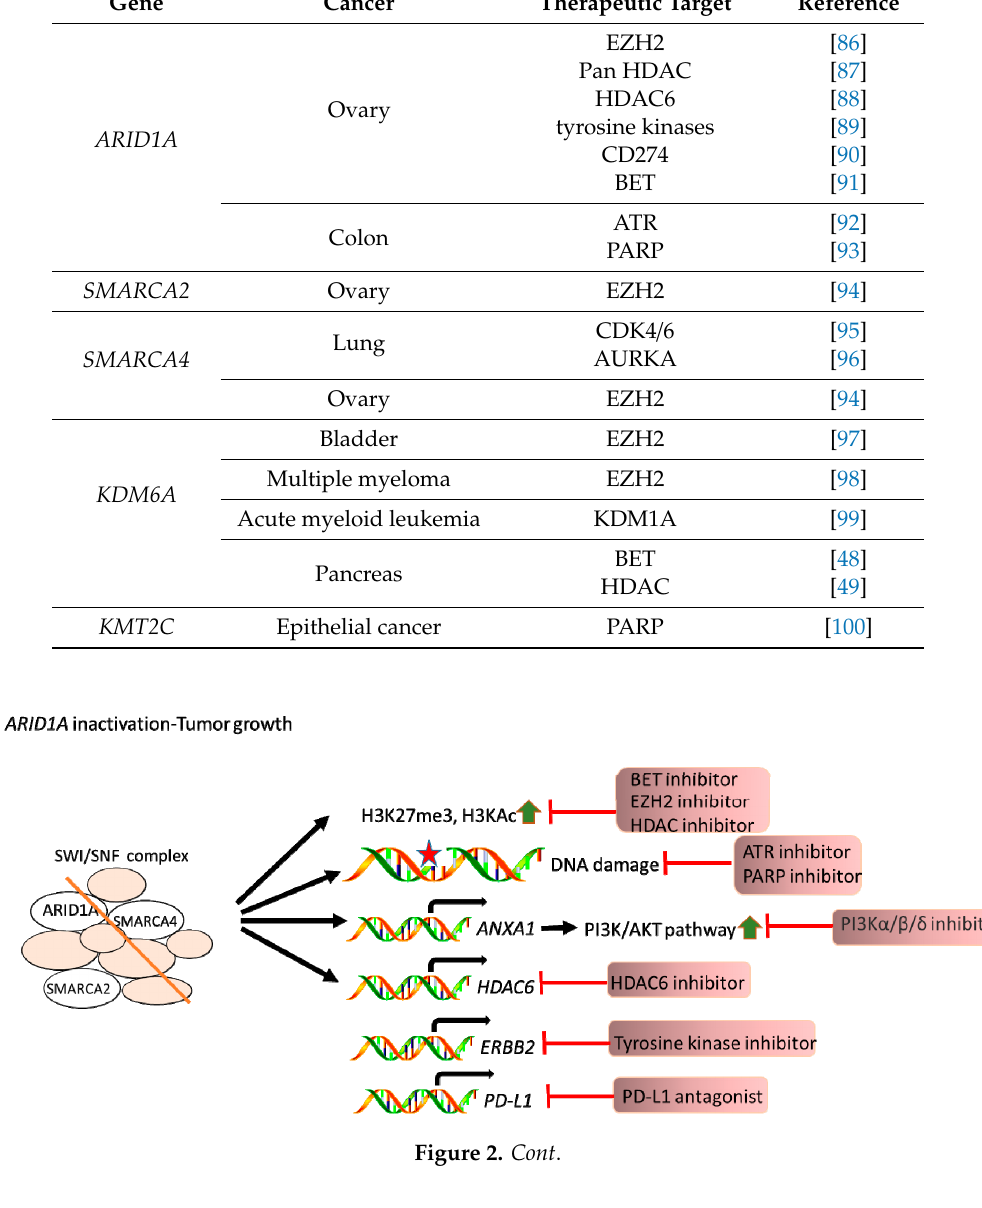
Figure 2. Loss of ARID1A, KDM6A, KMT2C, and KMT2D triggers synthetic lethal opportunities for cancer treatment. ( A ) ARID1A is a member of the SWI/SNF chromatin-remodeling complex that regulates transcription and nucleosome condensation. The blockage of specific oncogenic pathways was defined as a potential strategy in ARID1A-deficient cells. ( B ) KDM6A and KMT2C/KMT2D represent lysine demethylase and methyltransferase, respectively. The inactivation of KDM6A, KMT2C, and KMT2D is associated with a closed chromatin structure that is specifically sensitized by the indicated inhibitors. 5. Conclusions In the present review, we summarized the mutations of epigenetic regulators, including ARID1A , SMARCA2 , SMARCA4 , KDM6A , KMT2C , KMT2D , and BRD4 in GI cancers—in particular, pancreatic cancer—and found these regulators to be frequently mutated. The screening of tumor cells by utilizing chemicals, siRNAs, and shRNAs helps to identify therapeutic targets in epigenetic regulator-mutated cancers. However, the context dependency for each neoplasia needs further examination for the possible broad-spectrum application of the therapeutics mentioned in Table 3 across multiple tumor types. Accordingly, the screening strategy that targets multiple cancer types with a mutation in the same epigenetic regulator (for example, the ARID1A mutation in ovarian and colon tumors) may aid in the identification of therapeutics. This strategy could help advance the treatment of epigenetic regulator-mutated cancers. Author Contributions: Yu-Hsuan Hung, Ming-Chuan Hsu, Li-Tzong Chen, Wen-Chun Hung and Mei-Ren Pan helped to complete the manuscript; all authors read and approved the final manuscript. Funding: We acknowledge the support from the following grants: (1) KMUH107-7R32 and KMUH-107-7R31 from the Kaohsiung Medical University Hospital; (2) MOHW107-TDU-B-212-112-015 from the Ministry of Health and Welfare, Taiwan; (3) KMU-DK108011 from KMU-KMUH Co-Project of Key Research; (4) 105-2314-B-037-038-MY3 and 106-2314-B-037-049-MY3 from the Ministry of Health and Welfare, Taiwan; (5) 108CM-KMU-06 from Kaohsiung Medical University; (6) KMU-TC108A04 from Kaohsiung Medical University Research Center Grant.